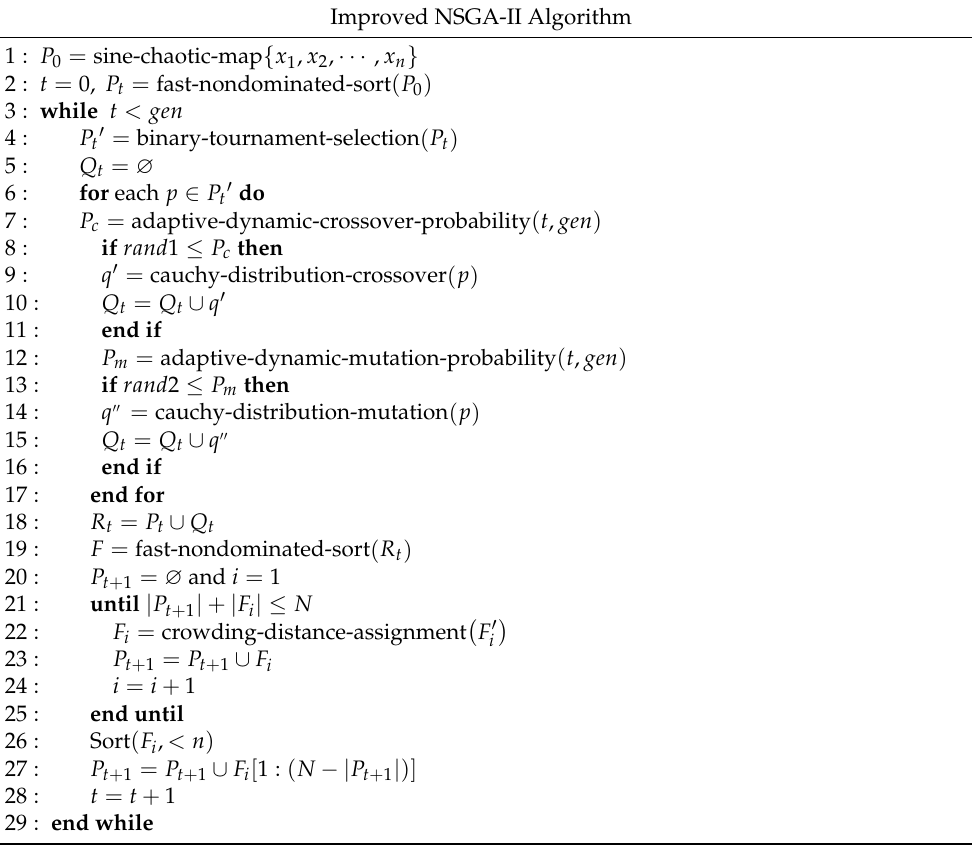
Table 4. The procedure of using the improved NSGA-II for design optimization. Improved NSGA-II